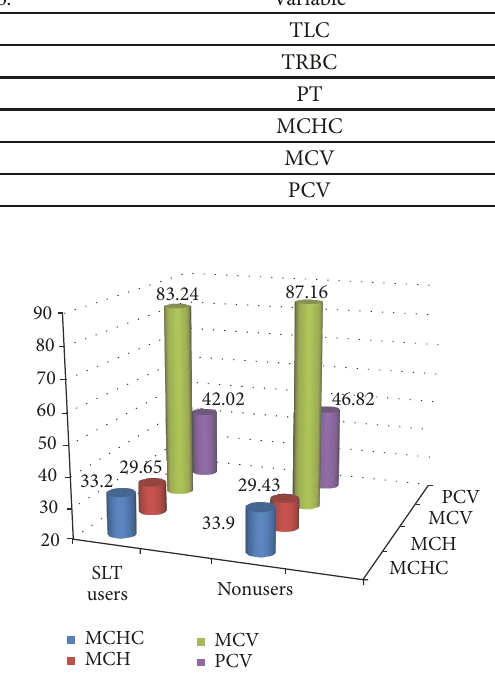
Figure 3: Comparison of MCHC, MCH, MCV, and PCV between SLT users (exposed) and